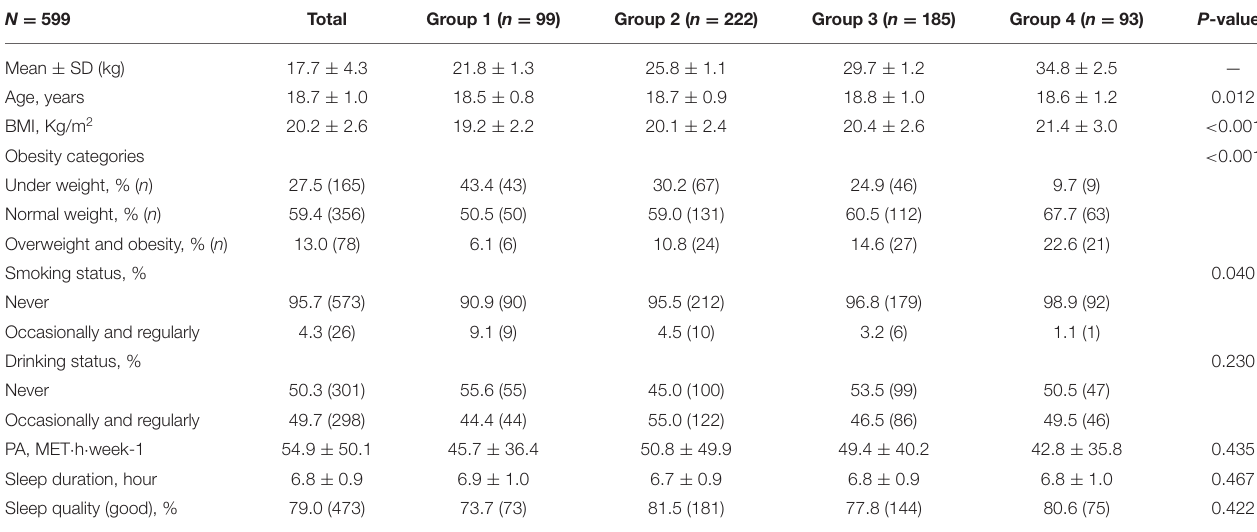
TABLE 1 | Participants’ characteristics according to categories of handgrip strength a . N = 599